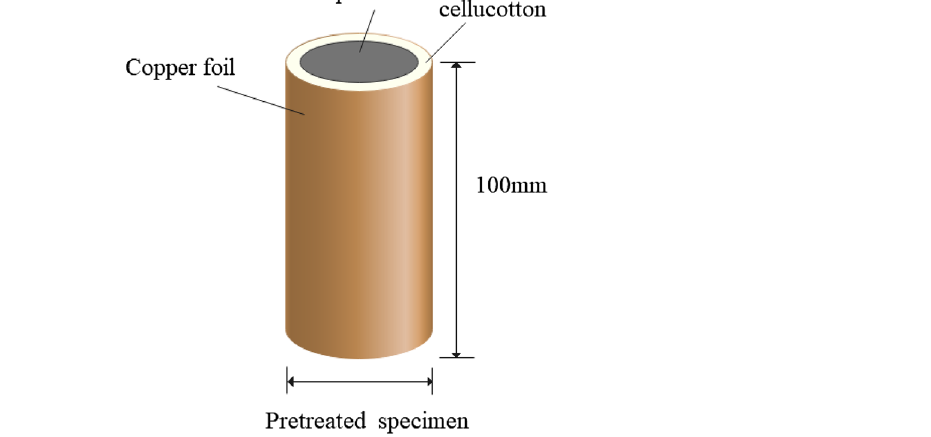
Figure 1. Preparation of specimen.